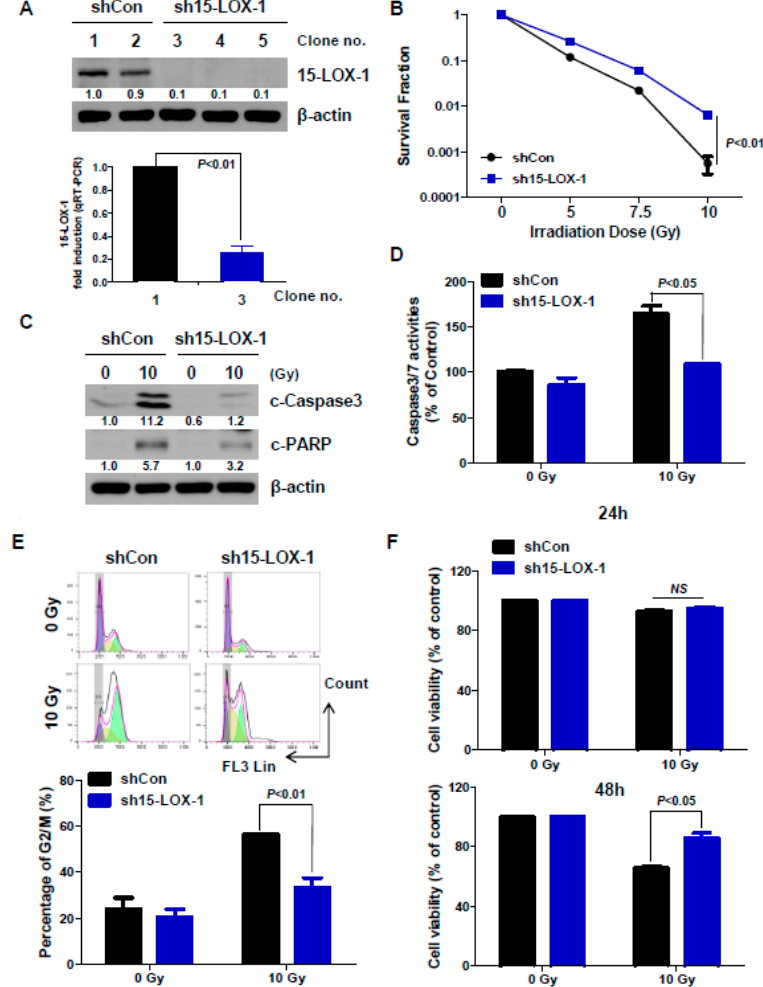
Figure 3. The absence of 15-LOX-1 decreased radiation sensitivity. ( A ) DLD-1 cells were